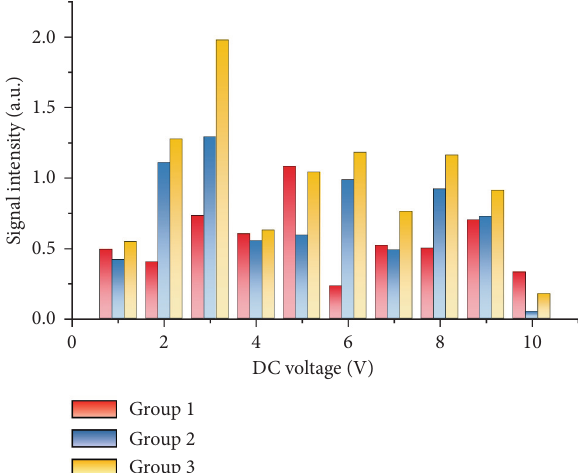
Figure 5: DC voltage acquisition results.